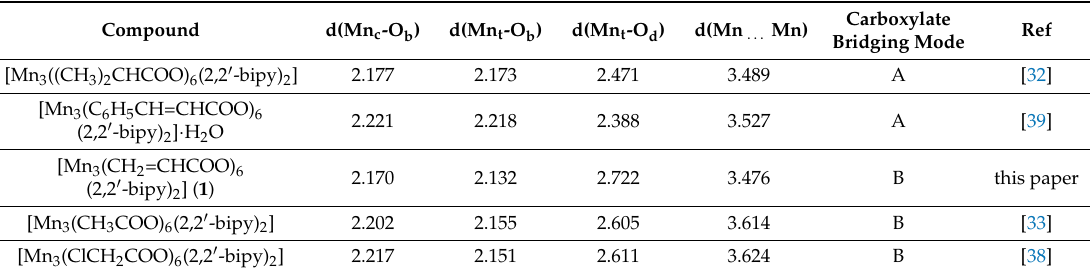
Table 3. Structural parameters (Å) for trinuclear compounds of the type [Mn 3 (RCOO) 6 (2,2 ′ -bipy) 2 ] and carboxylate bridging mode.